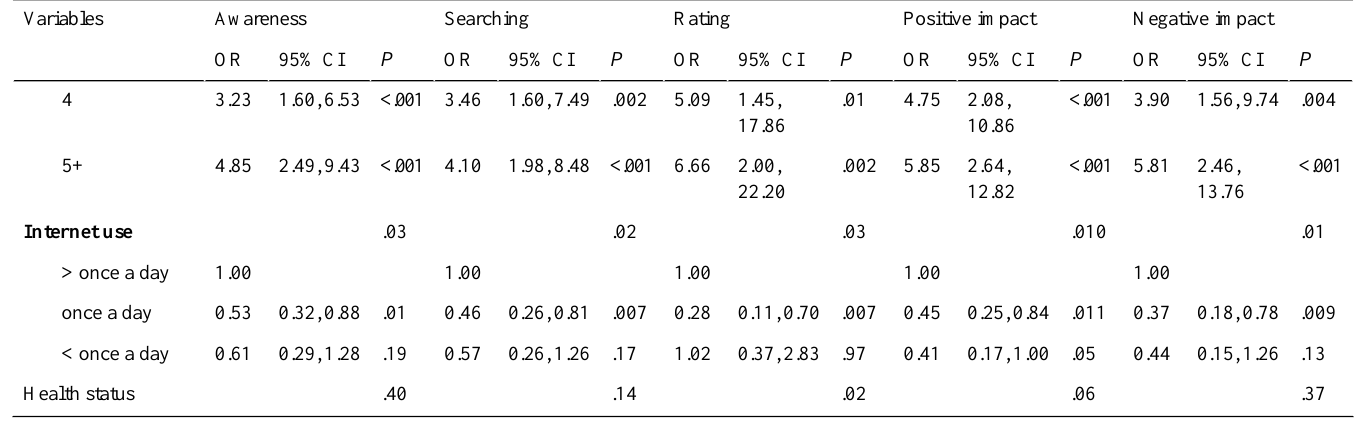
Table 6. Binary multivariate logistic regression analysis associated with physician-rating website relevant issues (weighted sample). 881.741068.71703.951160.571304.15–2 Log-Likelihood 0.2780.2590.2940.2680.276Pseudo R2 (Nagelkerke)